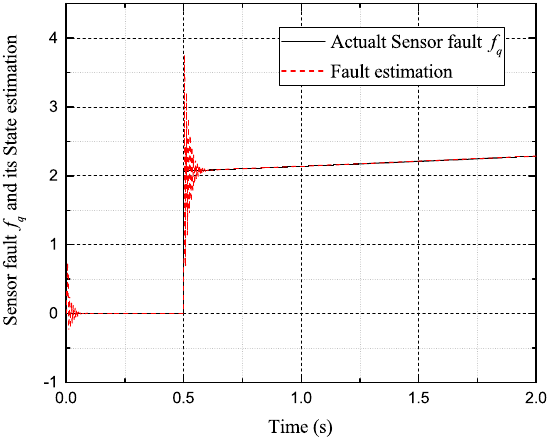
Figure 7. Sensor fault f q and its estimated value ˆ f q